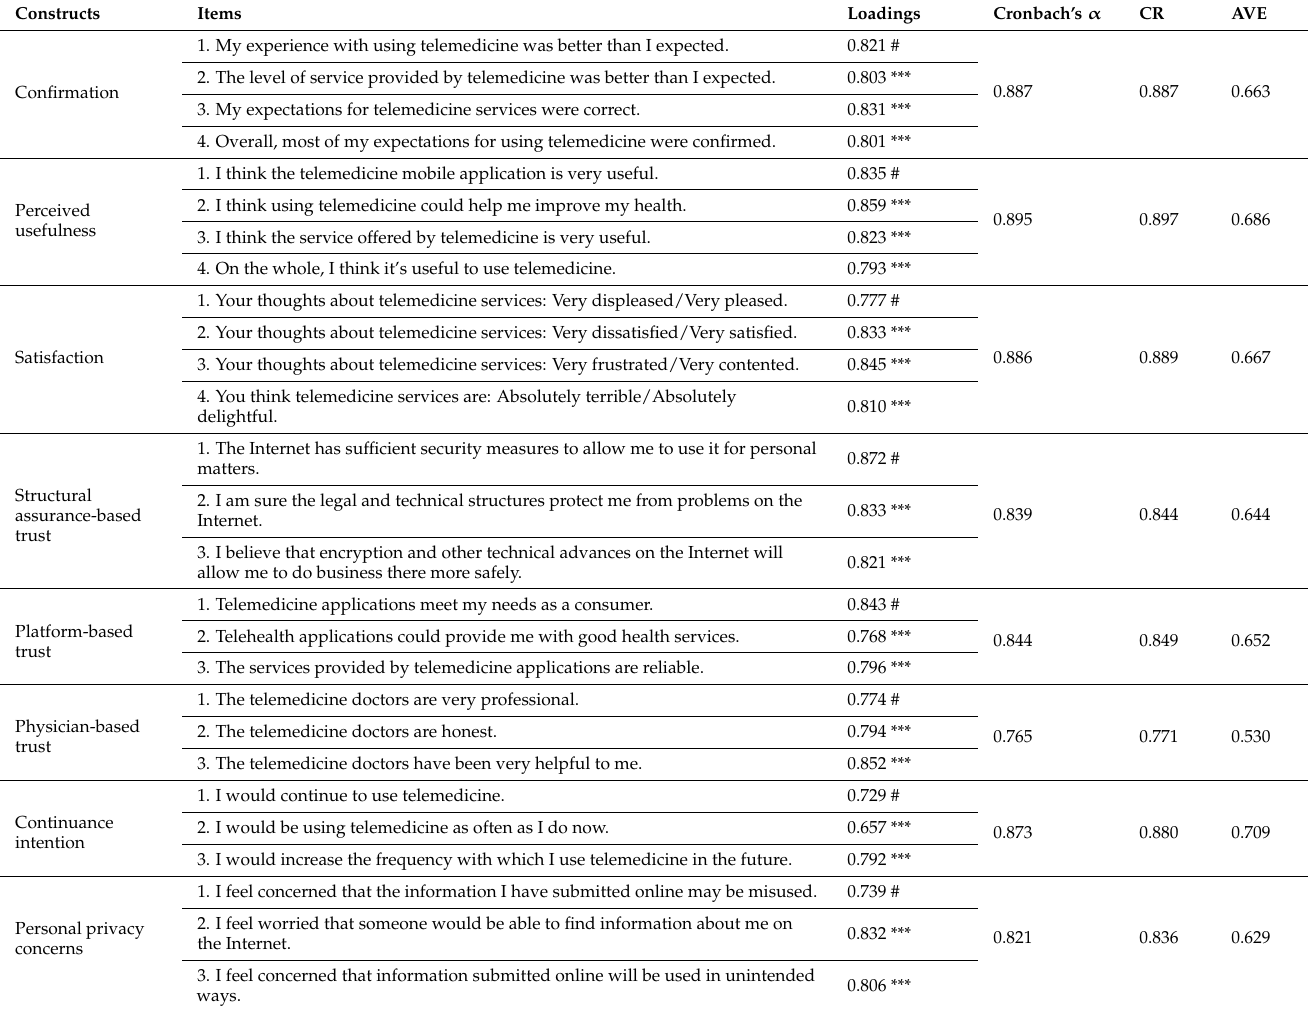
Table 2. Measurement model